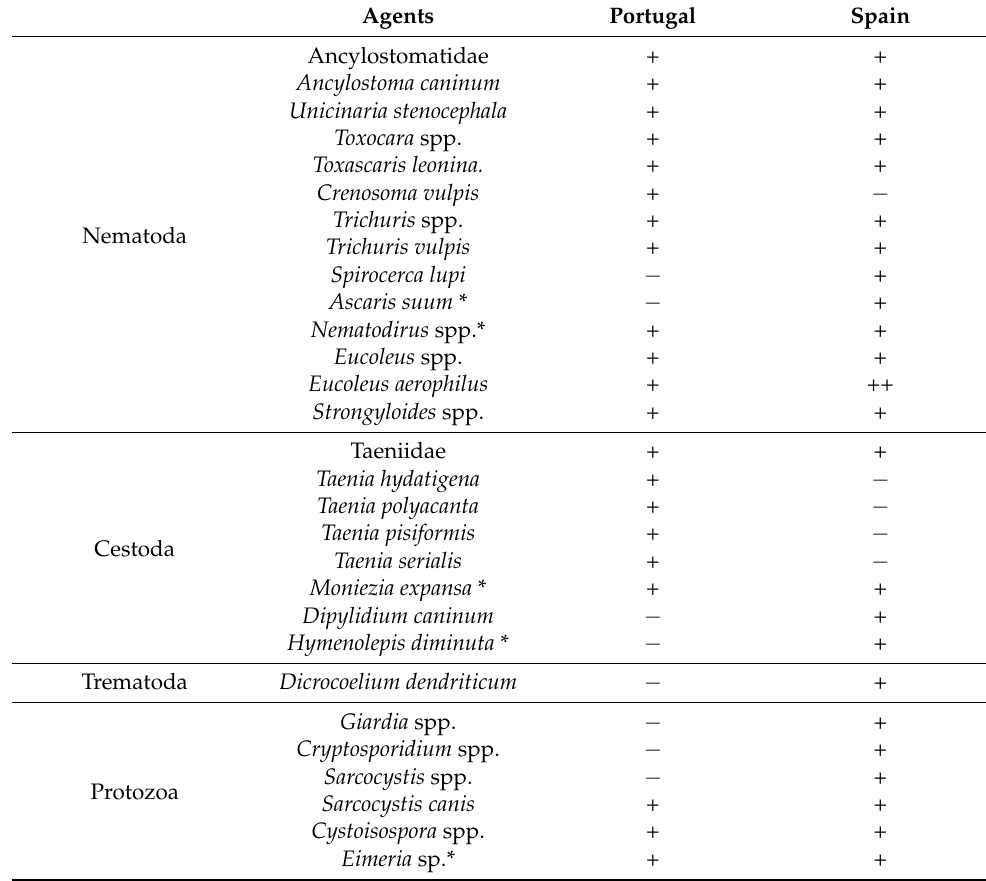
Table 1. Gastrointestinal parasites reported in wolves from Portugal and